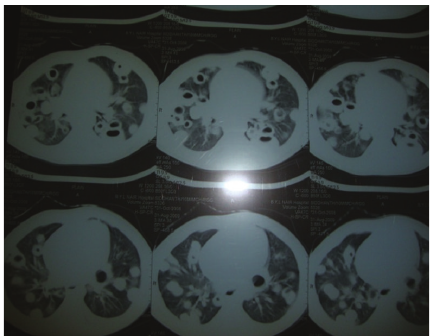
Figure 2: Computed tomography showing bilateral cavitary nod- ules and